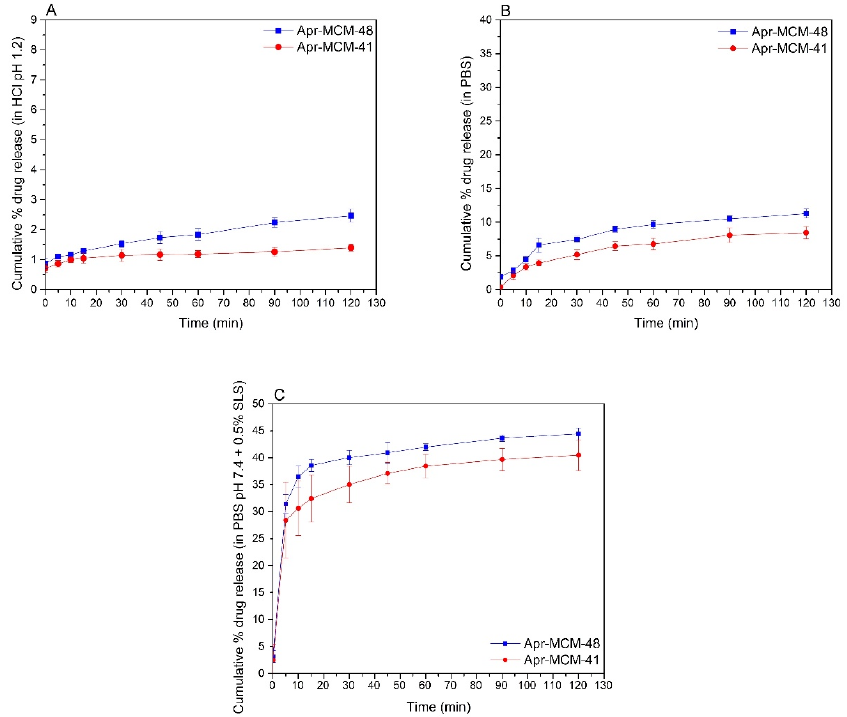
Figure 10. Release profile of aprepitant from MCM-41 (Apr-MCM-41) and MCM-48 (Apr-MCM-48) particles in ( A ) aqueous HCl solution pH 1.2, ( B ) in PBS pH 7.4, and ( C ) in PBS pH 7.4 in the pres- ence of 0.5% w/v